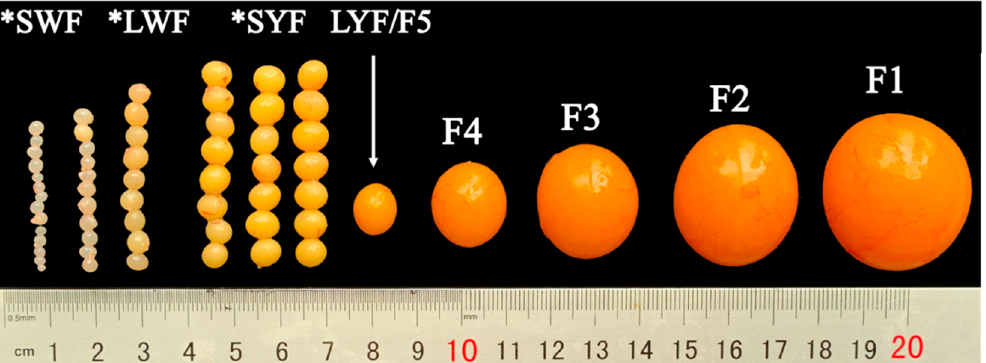
Figure 1. Ovarian follicles of laying hens. Asterisks indicate prehierarchal follicles; SWF: small white follicle; LWF: large white follicle; SYF: small yellow follicle; F5–F1 represent hierarchal follicles, which are sorted from smallest to largest in diameter. F5 represents the most recently selected follicle (LYF: large yellow follicle). Table 1. Parameters of follicles around follicle selection.